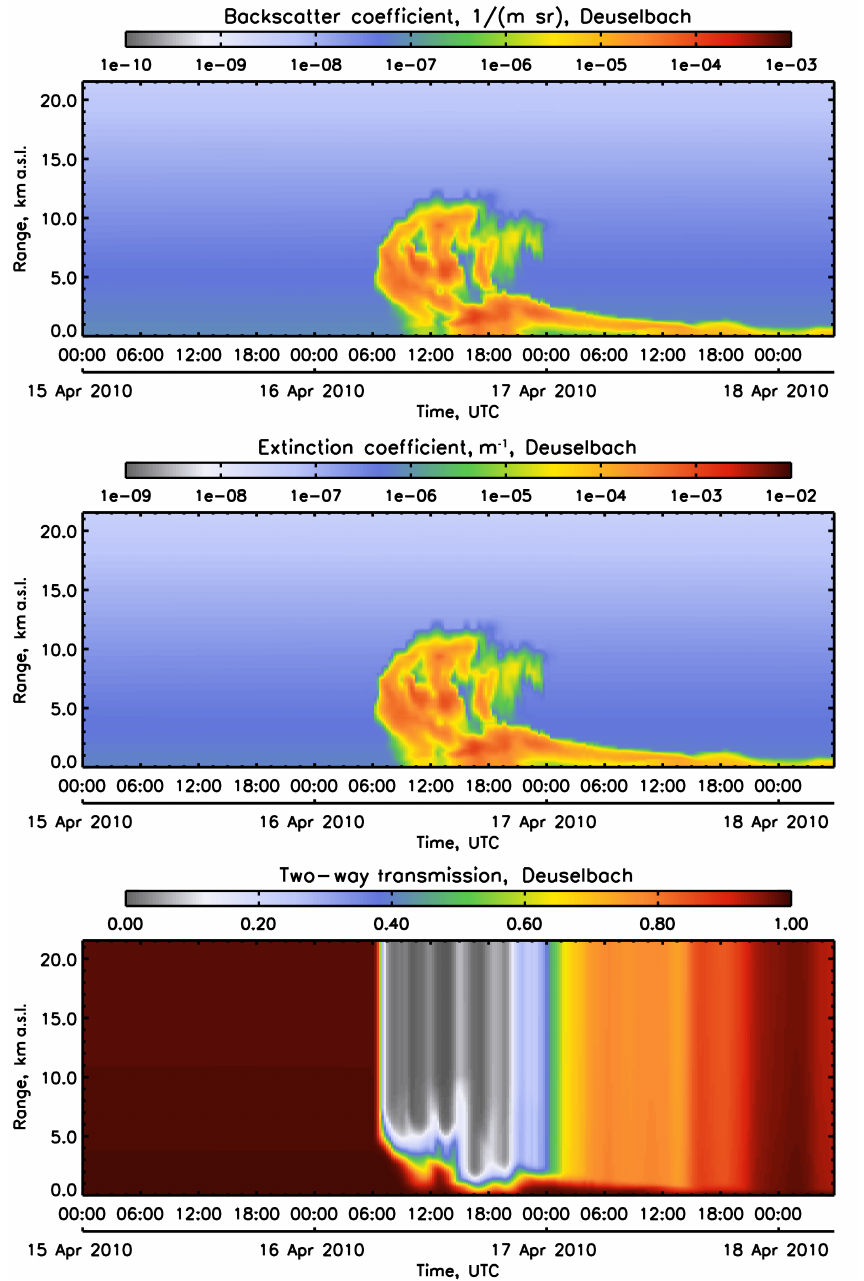
Figure 12. Time–height cross section of total backscatter coefficient, extinction coefficient, and two-way transmission, calculated by the forward model based on COSMO-ART output at Deuselbach station (western Germany). The vertical coordinates are given in kilometers above sea level (a.s.l.). The forward model used temperature, pressure, and volcanic ash particle data (no clouds, rain, fog, background aerosol, or other scattering objects). The two-way transmission is near 1 over clean-air conditions. Above ash layers, however, the two-way transmission has a value of only